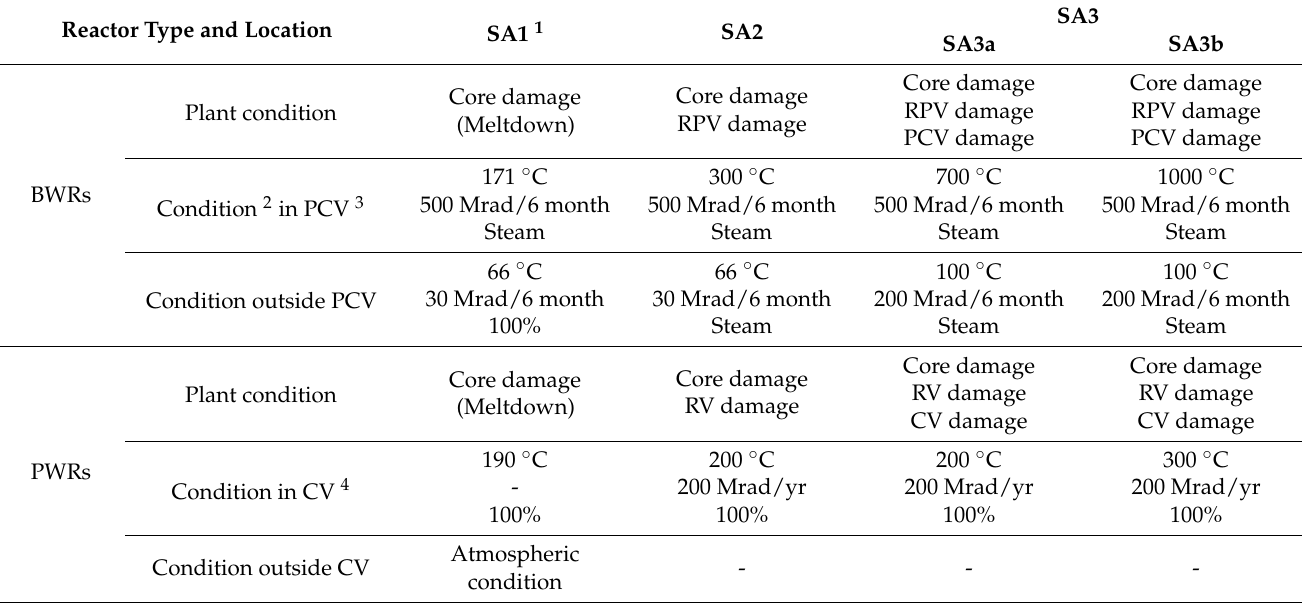
Table 3. Severe accident states—SA1 to SA3b—for NPP reactors.